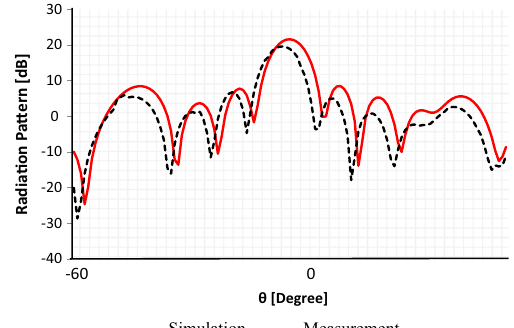
Fig. 12 Comparison of 2D radiation pattern 4